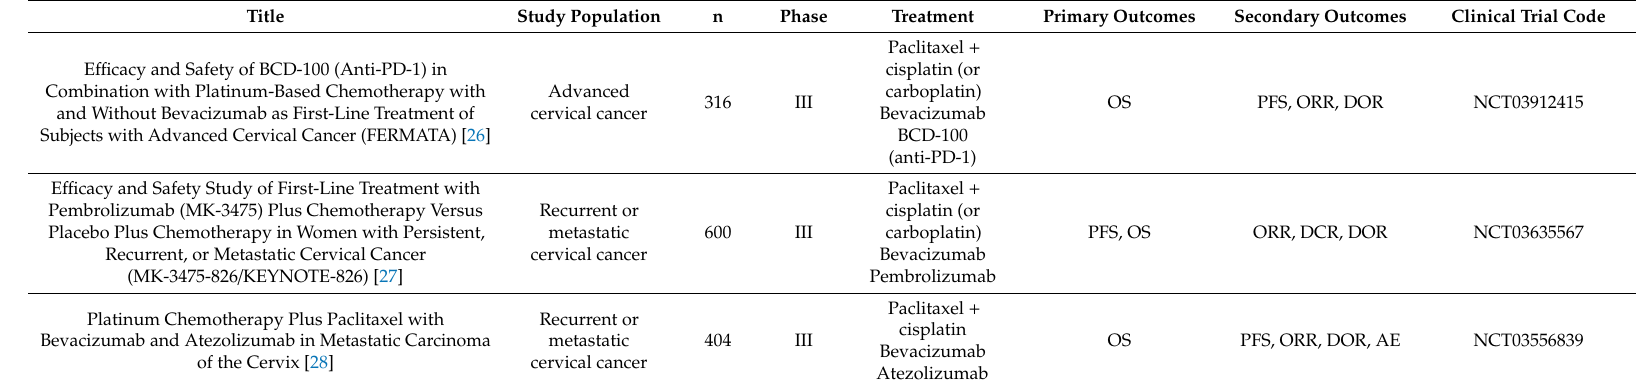
Table 3. Ongoing clinical phase III trials, chemotherapy with immune checkpoint inhibitors (ICIs) for cervical